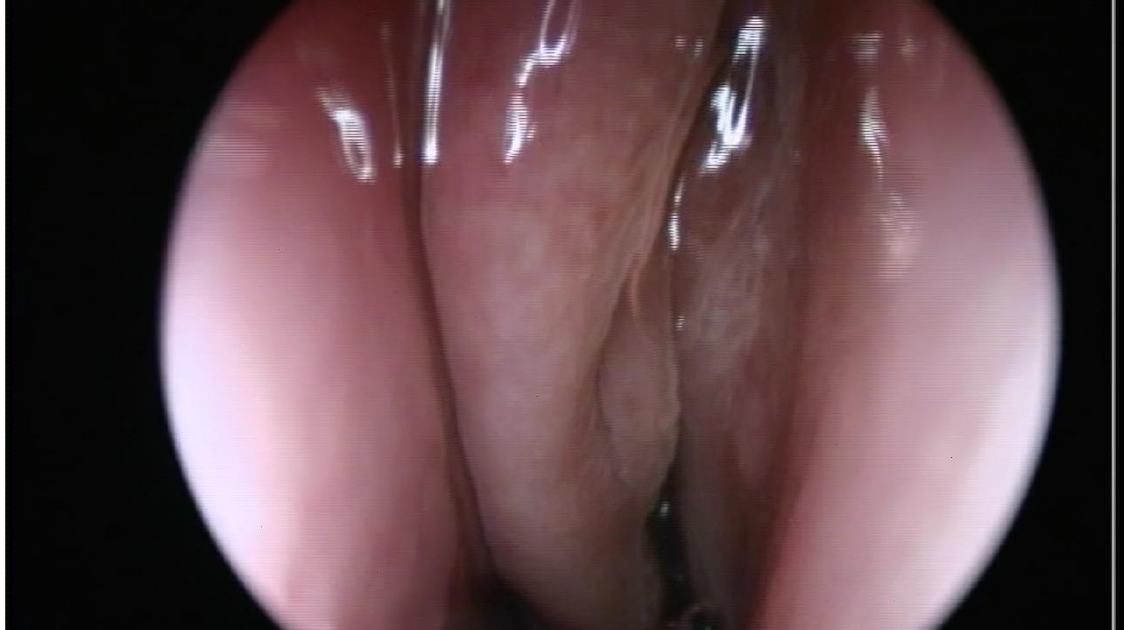
Figure 2. Endoscopic view of left middle meatus in a patient with odontogenic sinusitis showing a bulging uncinate.